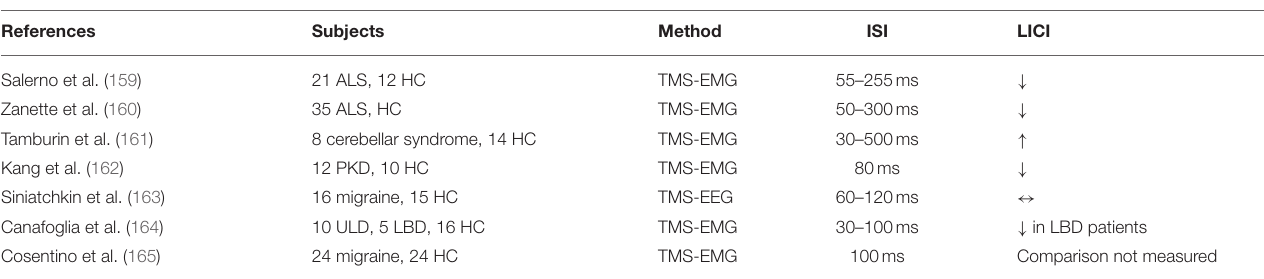
TABLE 14 | LICI in patients with other neurologic